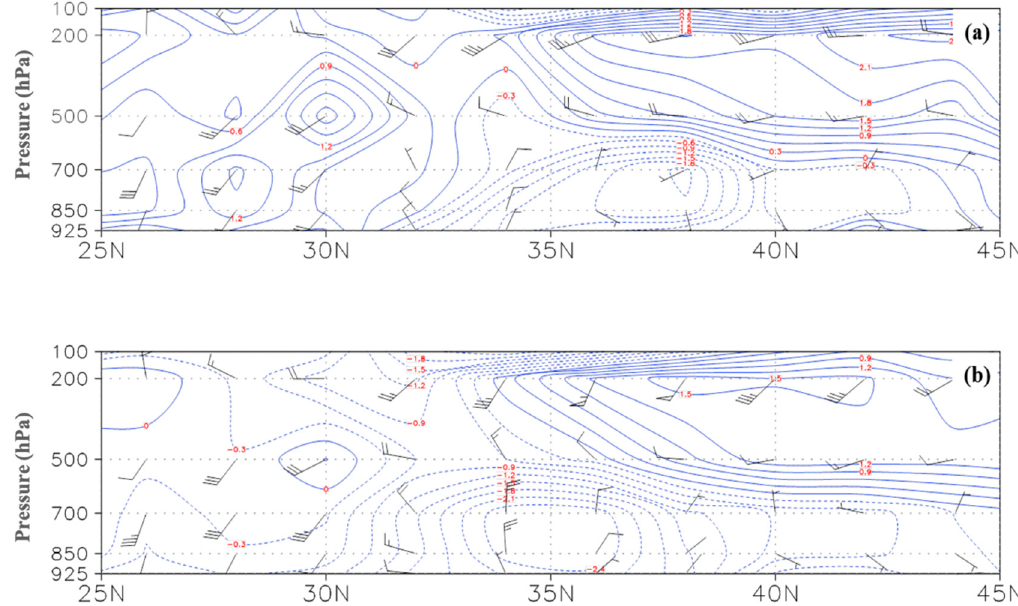
Figure 11. Normalized difference (difference between NORTH and GOOD composite means divided by EPS 51-member ensemble spread) for ( a ) meridional wind ( b ) geopotential heights between the NORTH subset and the GOOD subset valid at 0000 UTC 1 July (contoured blue, dashed negative, red contour labels). The wind vector (knots, black barbs, typical meteorological convention) of the GOOD subset are shown in ( a ) and the NORTH subset in ( b ). The ensemble forecast is initialized at 1200 UTC 28 June 2016.